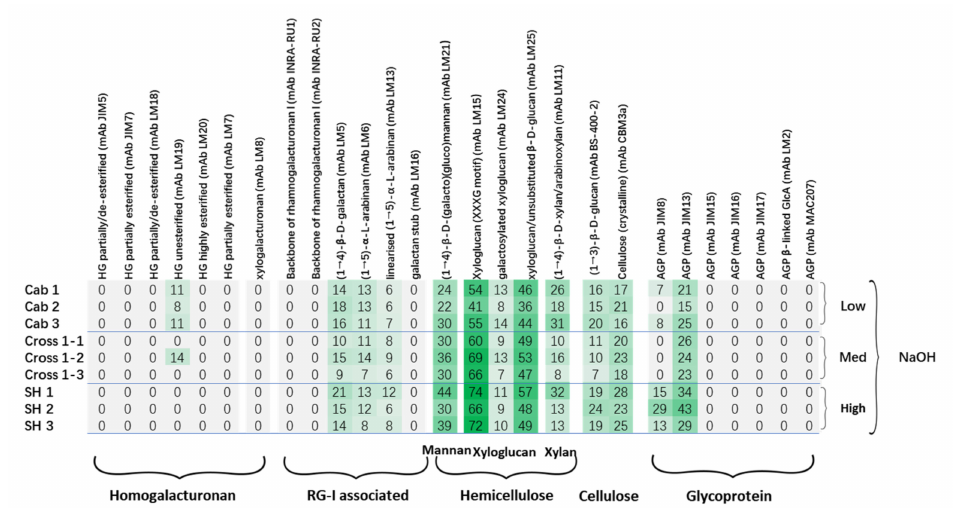
Figure 4. Comprehensive Microarray Polymer Profiling (CoMPP) analysis of NaOH extract of grapevine leaf cell wall AIR samples. The heatmap showed the relative abundance of plant cell wall glycan-associated structural motifs. The highest signal was set as 100, and others were adjusted accordingly; the color intensity is correlated to the mean spot signal. A cut-off (<5) was